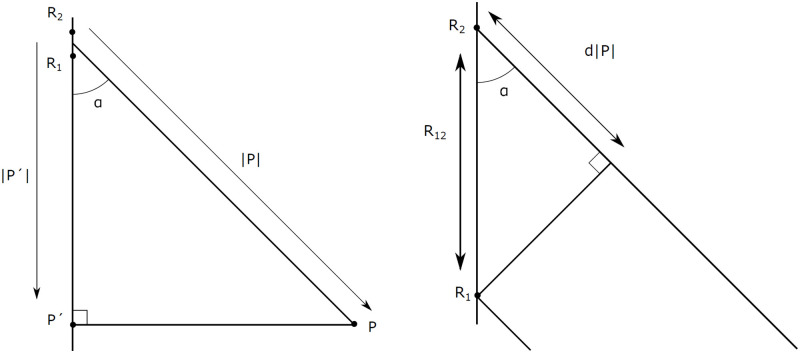
Definitions of incoming signals on two antennas R1 and R2.